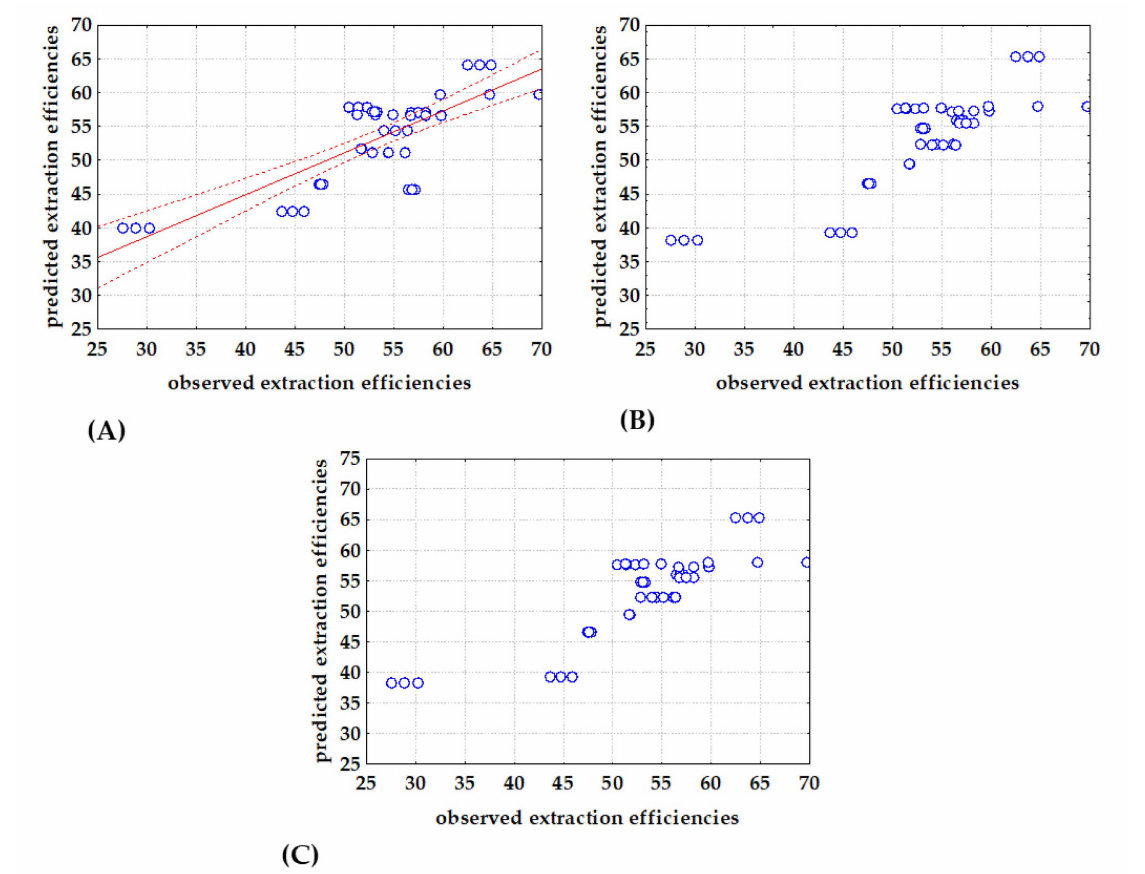
Figure 4. Comparison between observed and ( A ) MLR, ( B ) NLR and ( C ) PLR predicted extraction